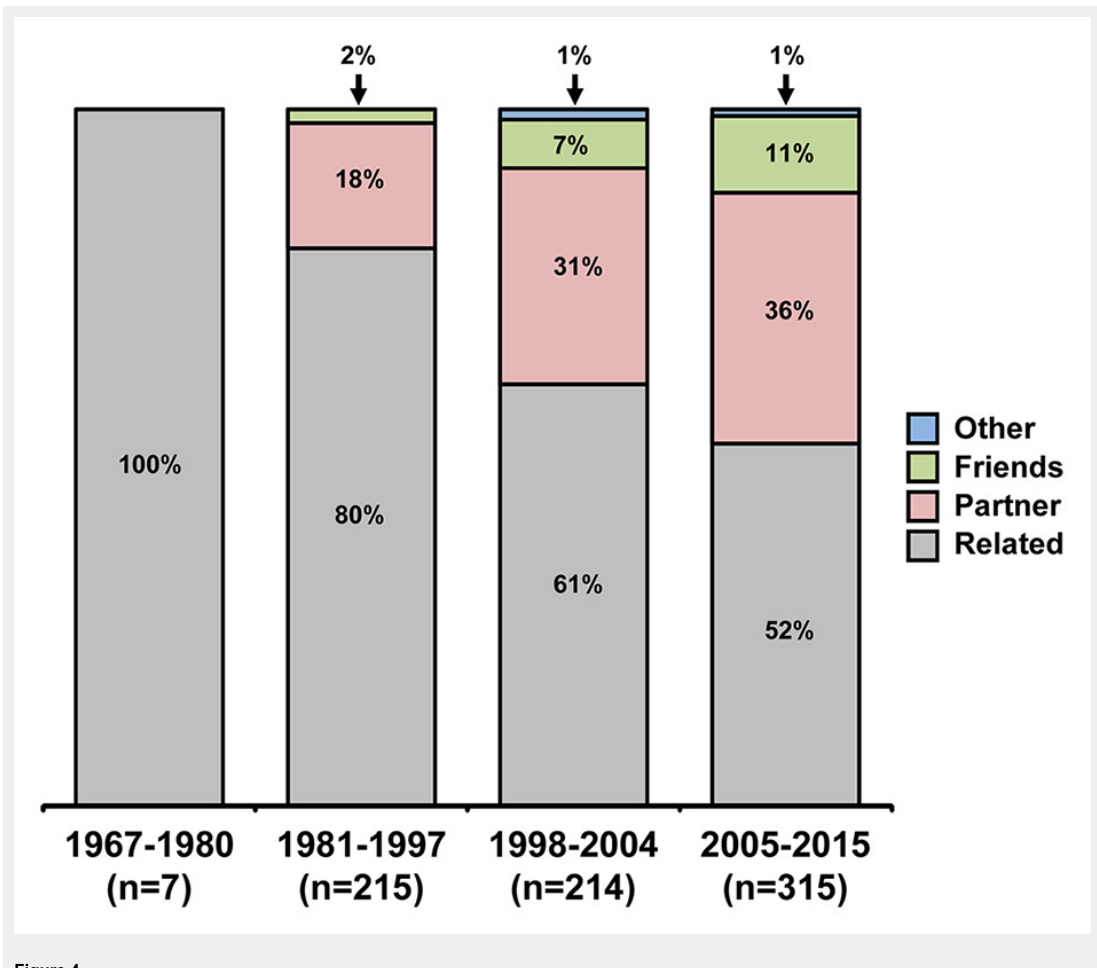
Figure 4 Relationship between living donors and the recipients of their kidneys, subdivided according to the predefined